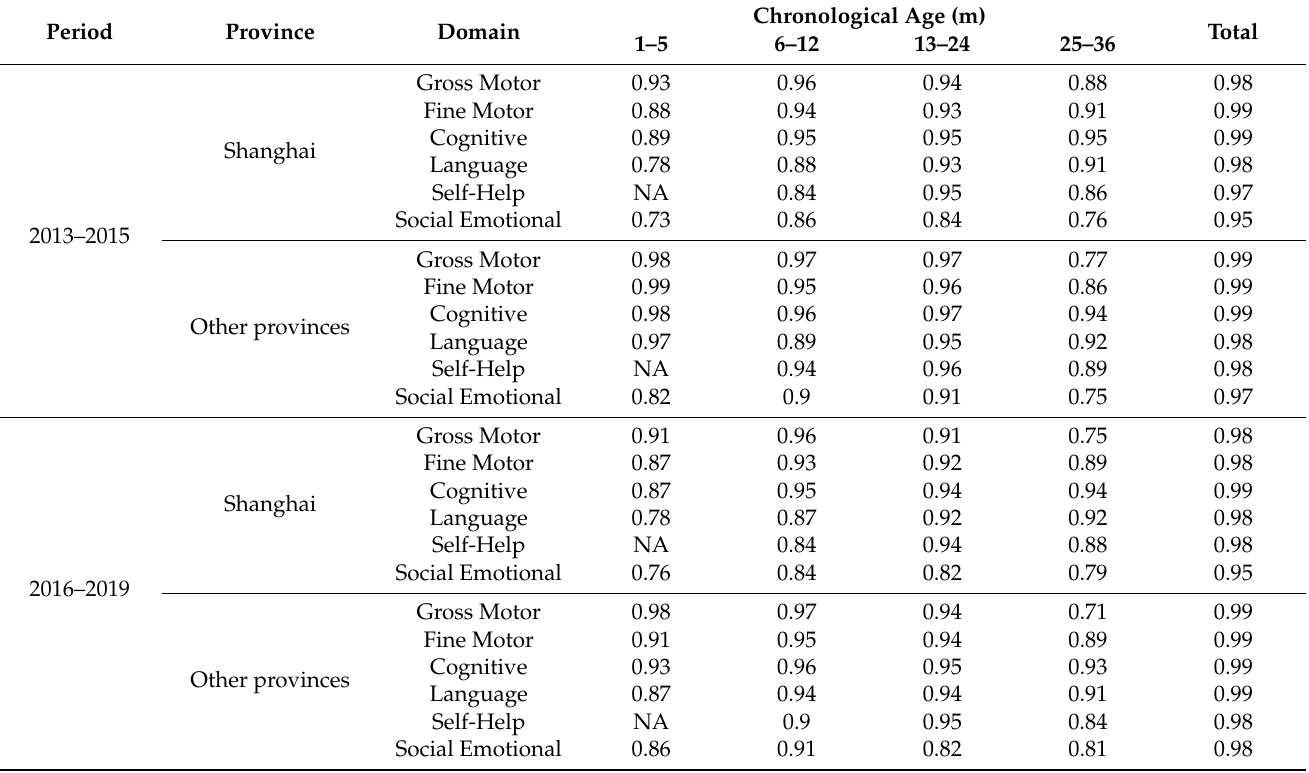
Table 4. Cronbach’s alpha coefficients of the C-LAP’s six domains by period and province. Period Province